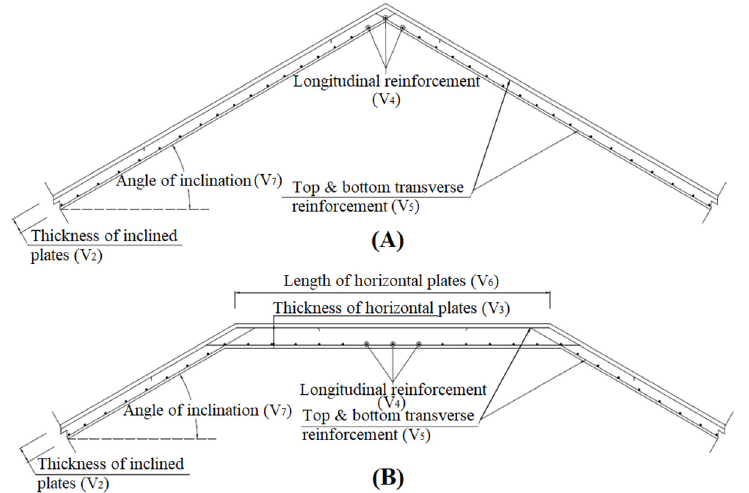
Figure 3. Folded plate roof section controlling design variables (V 2 through V 7 ): ( A ) “V” type folded plate roof section view; ( B ) Three-segment type folded plate roof section view.